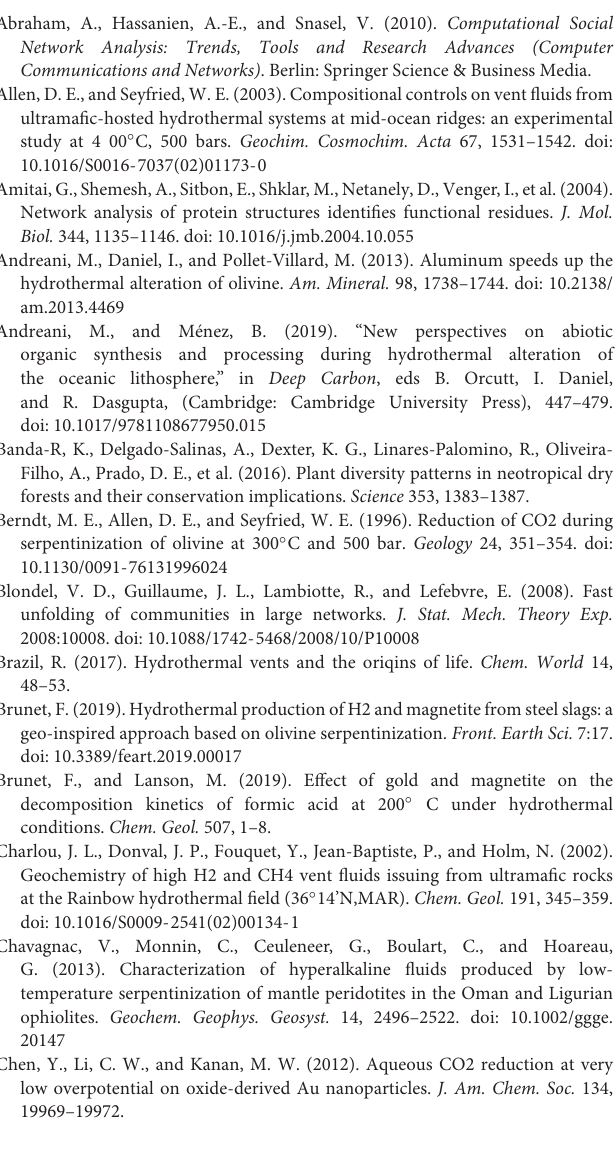
FIGURE S1 | (A) Temperature and pressure distribution of serpentinization experiments reported in literature. Diamonds and filled circles represent mineral free and bearing experiments, respectively. Individual networks representation of temperature (B) and pressure (C) of experiments. The heatmap color from cold to warm illustrates low to high values. Four communities of experiments explained Figure 5 captions. FIGURE S2 | Sensitivity test results on the cosine similarity threshold. The number of communities detected by Louvain algorithm is shown in the figure after